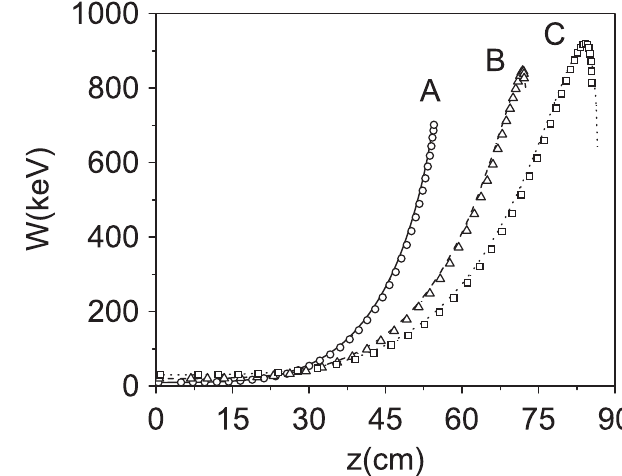
FIG. 5. Spatial evolutions of the electron energy: the solid line is the SARA model, the circles represent the data obtained in Ref.